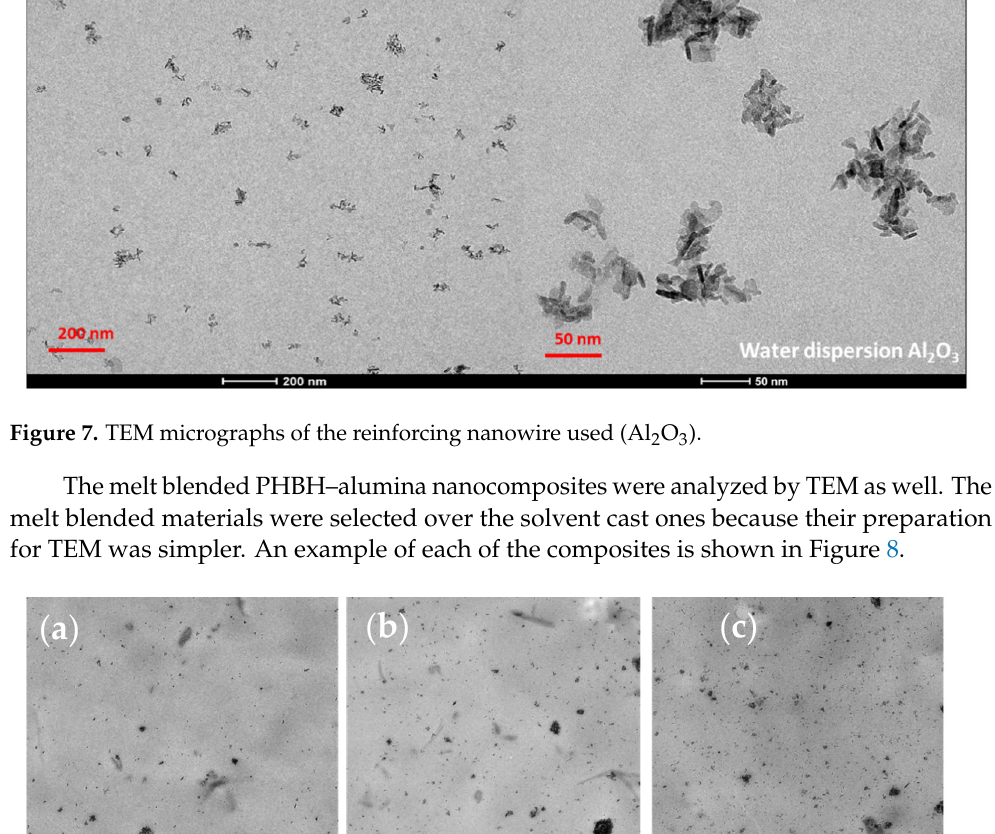
Figure 9. Binarized TEM micrographs for PHBH nanocomposites containing ( a ) 3 wt.%, ( b ) 5 wt.% and ( c ) 10 wt.% of alumina nanoparticles. Table 2. Number of measured particles, particle density, average particle size (area) and the corre- sponding standard error of the PHBH nanocomposites prepared by melt blending as a function of the alumina content, as computed by Automated Image Analysis. wt.% Al 2 O 3